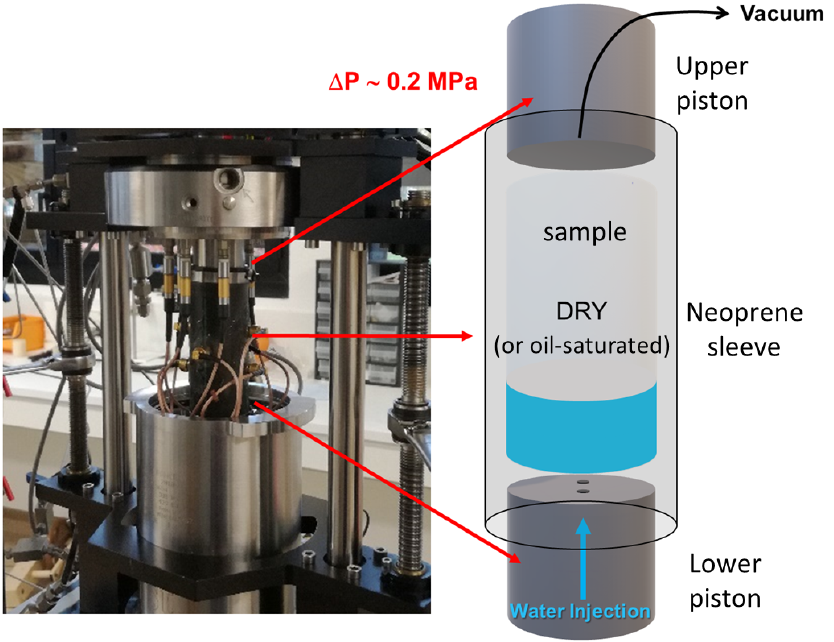
Figure 3. View of the open pressure vessel and sketch explaining the protocol used for the injection tests. Δ P is the fluid pressure difference between the bottom and top of the sample.